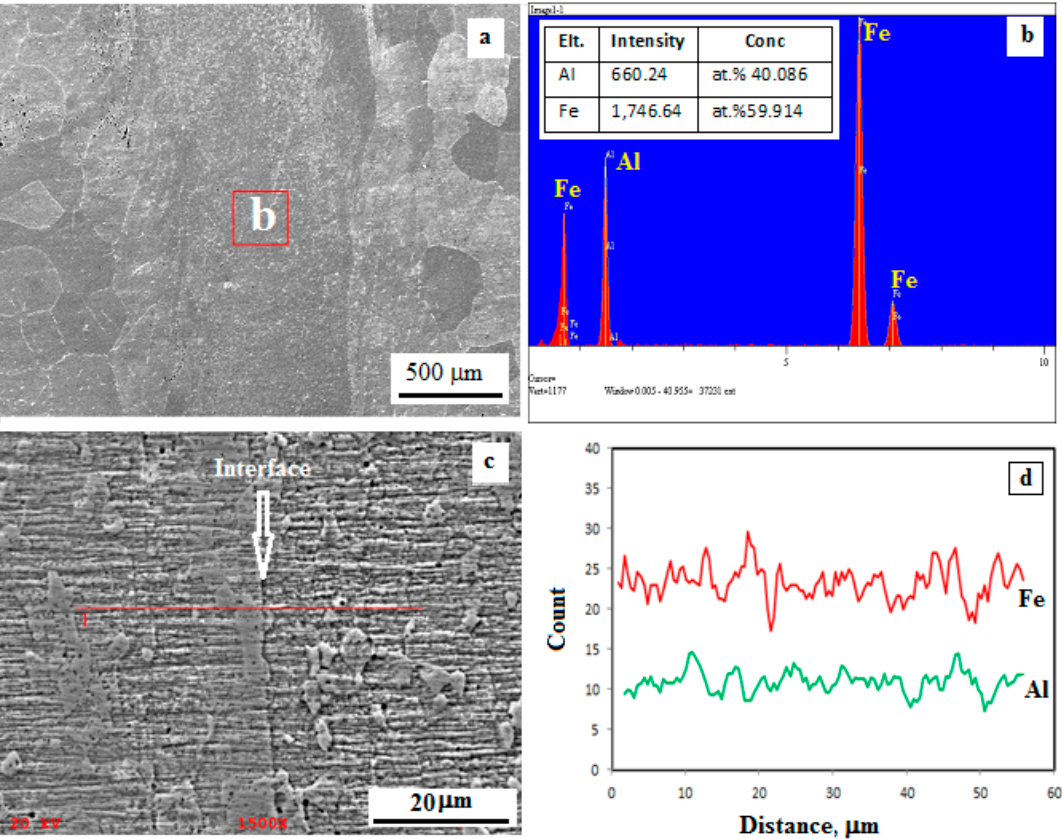
Figure 4. Scanning electron microscopy (SEM)-energy dispersive spectroscopy (EDS) analysis of welded sample for 7 s under 200 MPa forging pressure and 140 MPa friction pressure. ( a ) SEM micrograph; ( b ) EDS analysis; ( c ) SEM micrograph of weld interface; ( d ) line-scan analysis.